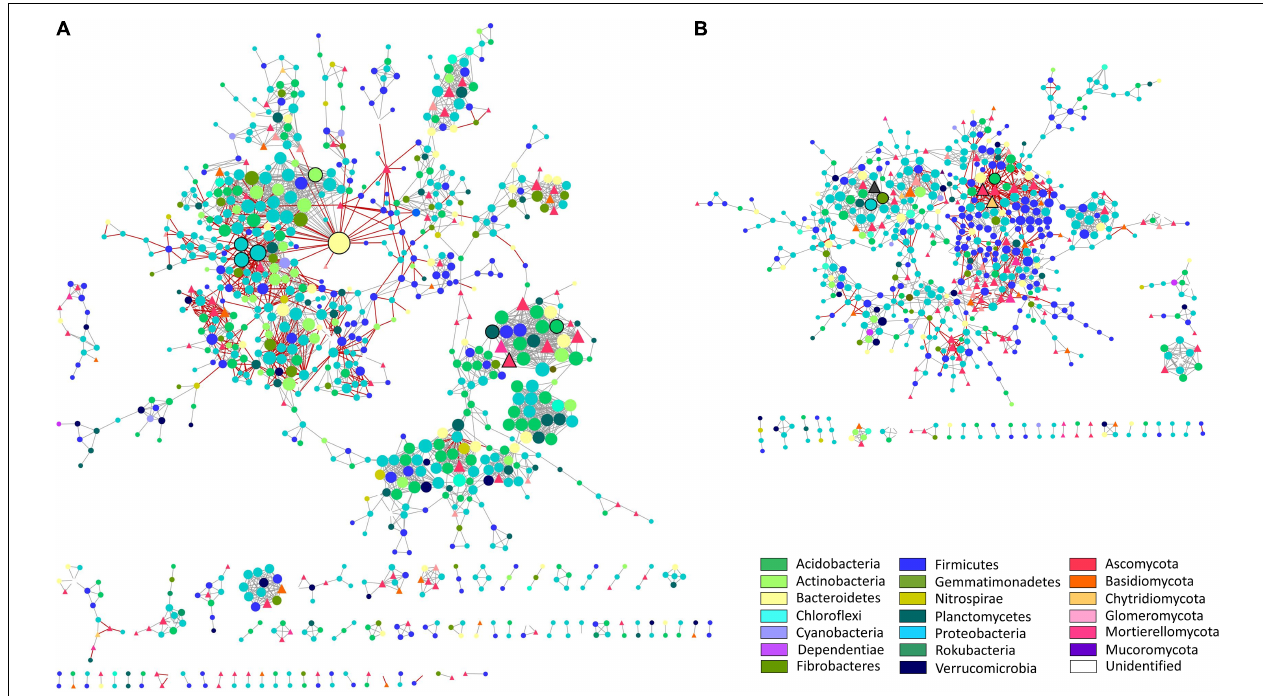
FIGURE 3 | Microbial interaction networks from susceptible and tolerant cultivar rhizospheres. (A) Susceptible cultivar rhizosphere bacterial and fungal interaction network in response to water deficit. (B) Tolerant cultivar rhizosphere bacterial and fungal interaction network in response to water deficit. Interactions were inferred from a global microbial operational taxonomic unit (OTU) ratio (deficit irrigated over full irrigated plants) abundance. Each node represents an OTU, and each edge represents a significant pairwise association between them (gray lines: positive co-response to water deficit; red lines: negative co-response to water deficit). Nodes in the shape of circles are bacteria, and nodes in the shape of triangles are fungi. Different colors of nodes represent distinct phyla. Node size is proportional to the number of connections (degree) for both networks (maximum node degree for SRz network is 39 and for TRz network is 20). Nodes with black border represent “responsive-to-water-deficit hub nodes” (1% of OTUs with the highest degrees in each network; eight SRz hub nodes; six TRz hub nodes).